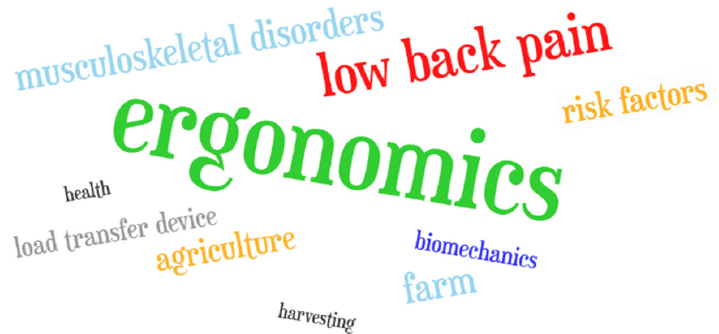
Figure 4. Keyword information clustering of the relevant papers.